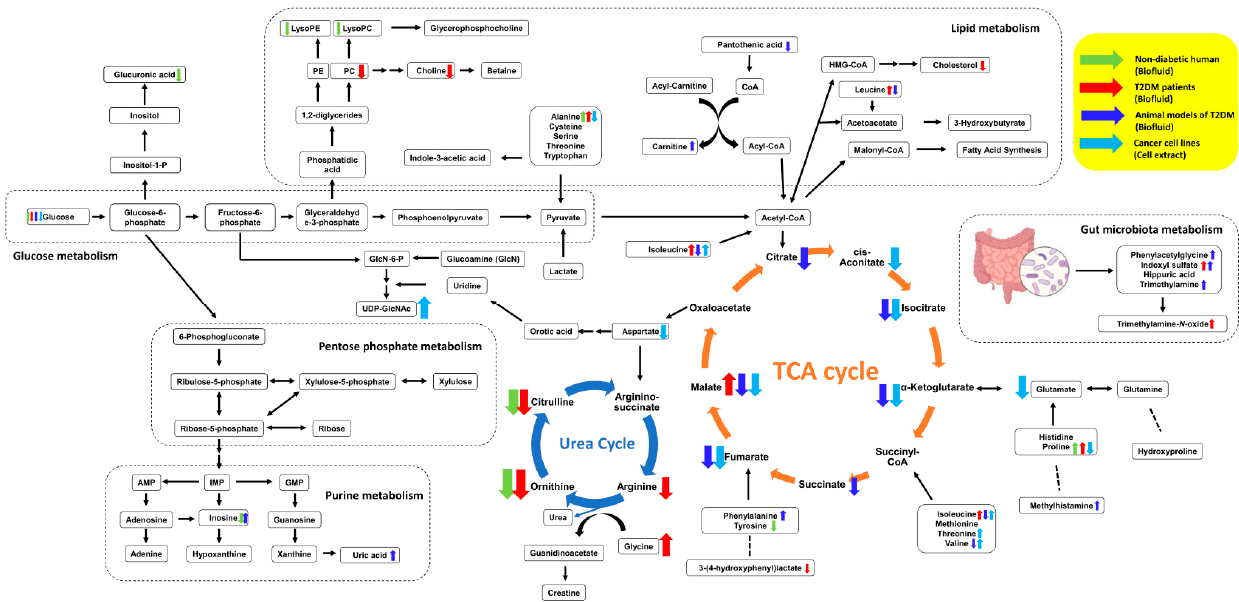
Figure 3. Pathways and metabolites significantly affected by metformin treatment in non-diabetic human (biofluid, green), T2DM patients (biofluid, red), T2DM animal models (biofluid, blue), and cancer cells (cell extract, sky blue).